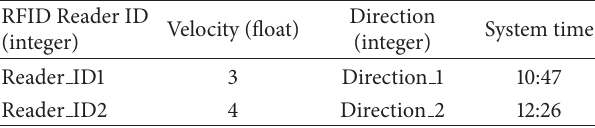
Table 6: Output table of the Tracking Service.